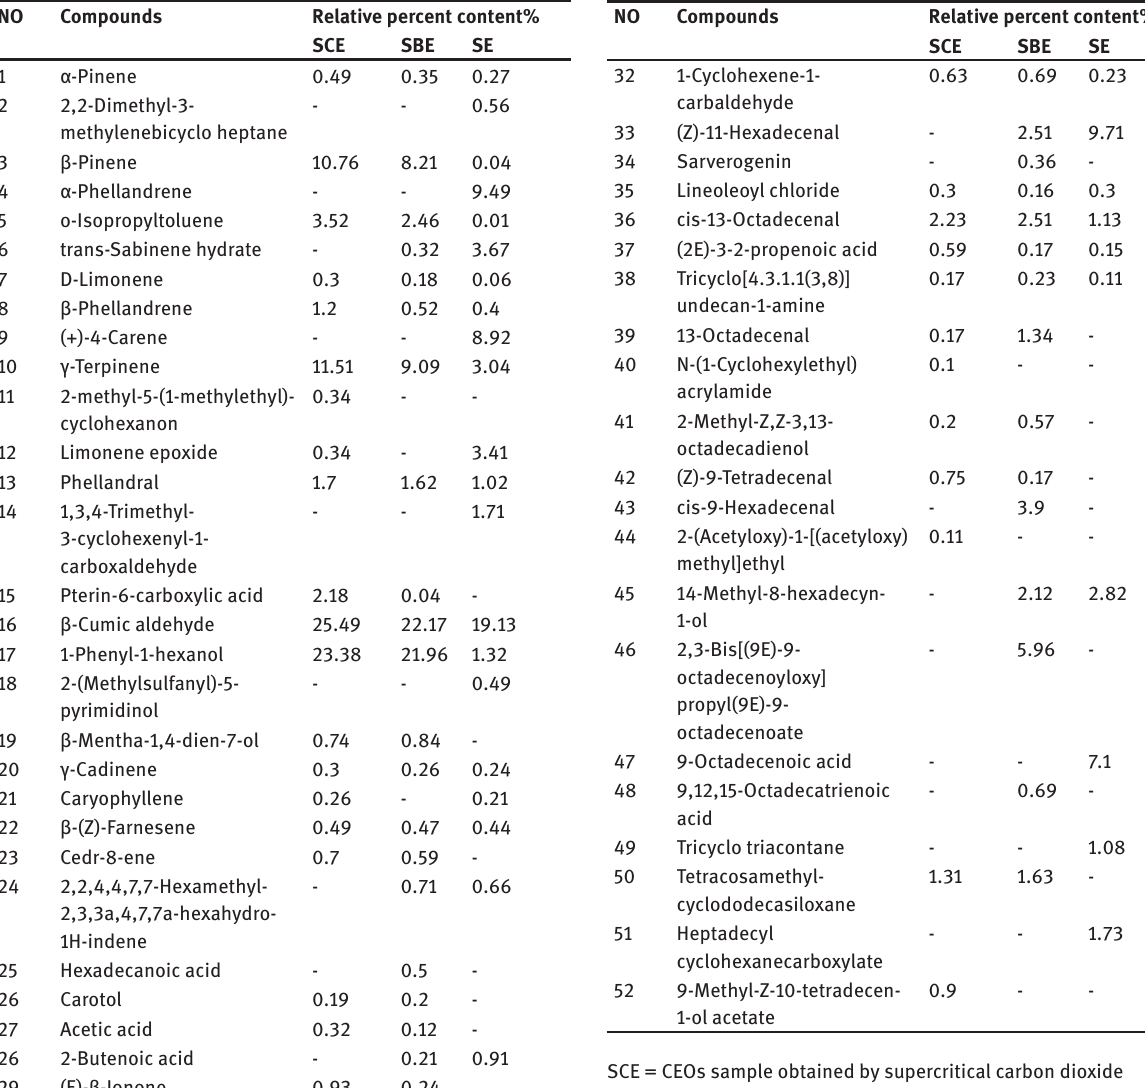
Table 1: Chemical composition of essential oils extracted from cumin seeds by 3 methods as determined by